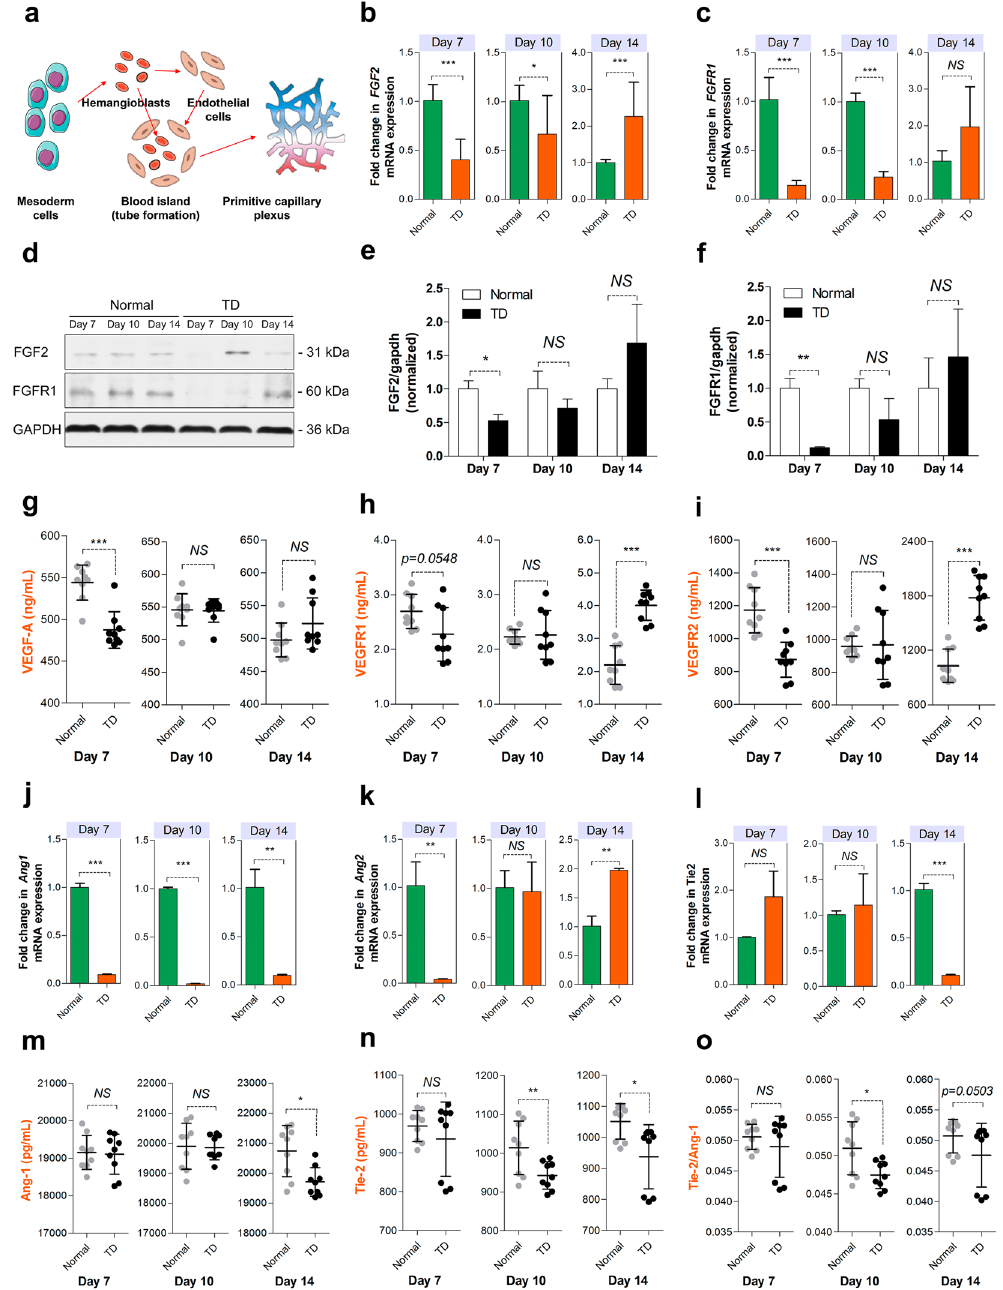
Figure 3. Tibial vasculogenesis is disturbed in TD chickens. ( a ) A schematic diagram illustrating the procedure of vasculogenesis. ( b , c ) qRT-PCR analysis of FGF2 and FGFR1 expression levels (normalized to GAPDH) in proximal TGPs sorted from normal and TD chickens at 7, 10 and 14 days, respectively. Data represent means ± s.e.m. (n = 3 biological replicates). * p < 0.05, *** p < 0.001, two-tailed unpaired t -test. NS, not significant. ( d–f ) Western blot analysis ( d ) and the quantitation ( e , f ) of the relative levels of FGF2 and FGFR1 protein expression in proximal TGPs derived from normal and TD chickens at 7, 10 and 14 days, respectively. (n = 3 in each group from three independent experiments). Data represent means ± s.e.m. * p < 0.05, ** p < 0.01, two-tailed unpaired t -test. NS, not significant. ( g–i ) VEGFA, VEGFR1, and VEGFR2 concentrations assessed by ELISA in serum. (n = 9 in each group from three independent experiments, 3 technical replicates per experiment). Data represent means ± s.d. *** p < 0.001, two- tailed unpaired t -test. NS, not significant. ( j–l ) qRT-PCR analysis of Ang1, Ang2 and Tie2 expression (normalized to GAPDH) levels in proximal TGPs sorted from normal and TD chickens at 7, 10 and 14 days, respectively. Data represent means ± s.e.m. (n = 3 biological replicates). ** p < 0.01, *** p < 0.001, two-tailed unpaired t -test. NS, not significant. ( m – o ) Ang1 and Tie2 concentrations assessed by serum ELISAs and Tie2/Ang1 ratios were determined. (n = 9 in each group from three independent experiments, 3 technical replicates per experiment). Data represent means ± s.d. * p < 0.05, ** p < 0.01, two-tailed unpaired t -test. NS, not